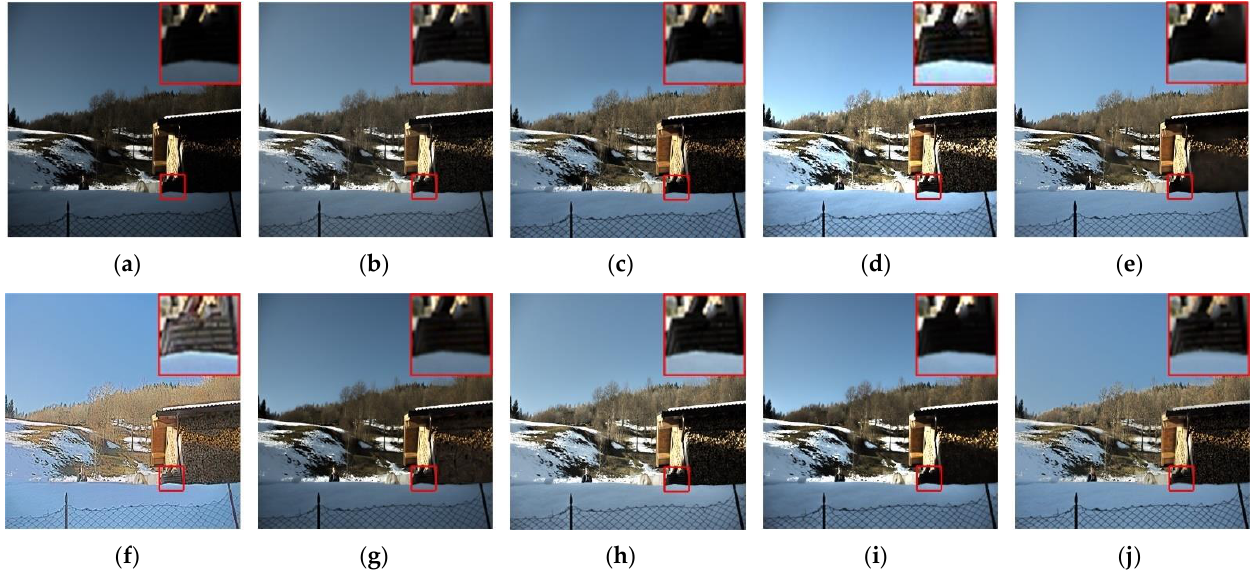
Figure 11. En hanced results of “House” image. ( a ) Original image; ( b ) BIMEF;( c ) MEF; ( d ) LIME; ( e ) Figure 11. Enhanced results of “House” image. ( a ) Original image; ( b ) BIMEF;( c ) MF; ( d )